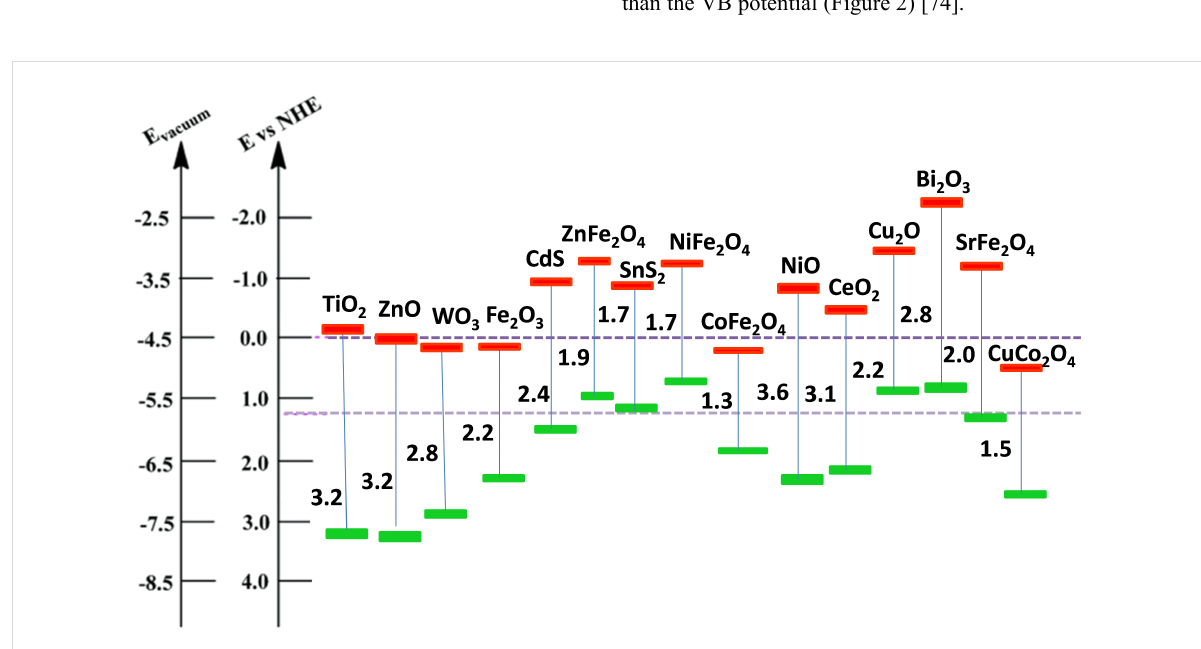
Figure 2: The band edge potentials and band gaps of different semiconductors that combine with TiO 2 for enhanced photocatalytic reduction of